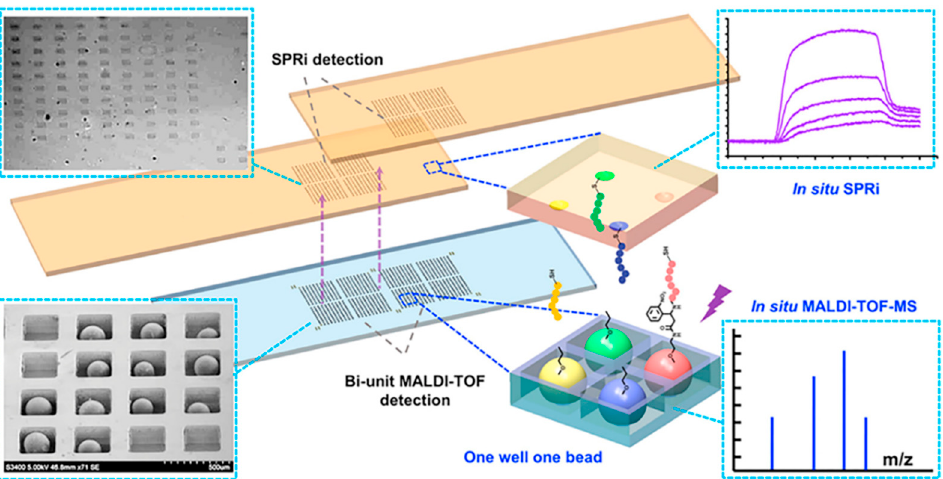
Figure 7. New methods for improving the speed of peptide screening. A high-throughput chip for screening, in which peptide beads were trapped in the microwell array for MALDI-TOF-MS detection and peptides were photocleaved in situ and imprinted onto the SPRi (surface plasmon resonance analysis imaging system) chips for SPRi detection. Reproduced from Reference [46] with permission. Copyright: 2014 American Chemical Society.